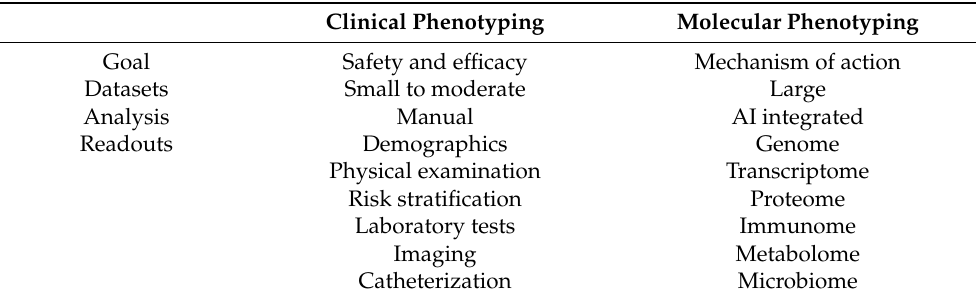
Table 2. Leveraging clinical trials, clinomics aim to achieve a comprehensive, deep phenotyping using a high precision, high throughput